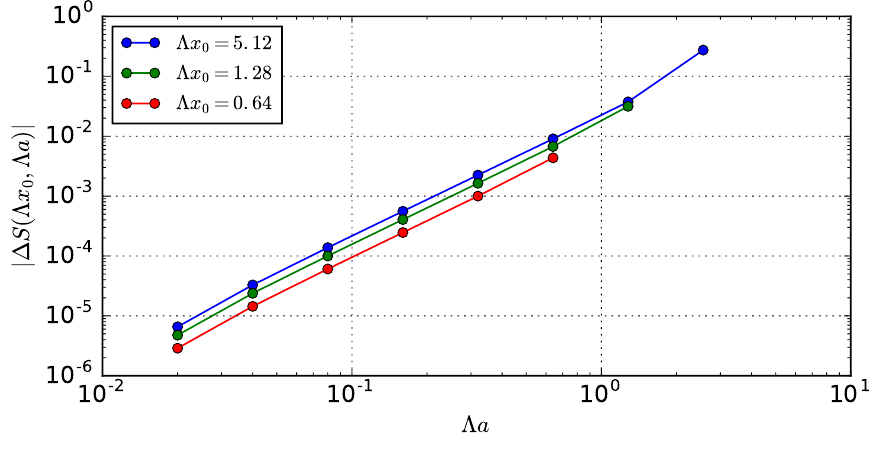
Figure 6 . Plot of the di(cid:11)erence j S ((cid:3) x 0 ; (cid:3) a ) (cid:0) S ((cid:3) x 0 ; (cid:3) a = 0 : 01) j that shows the convergence of this particular value of entropy upon iterative (cid:12)ne-graining of the sampling parameter used as a tool to compute it. The plotted di(cid:11)erence goes to zero approximately quadratically with (cid:3) a . S ( x ) to a (cid:12)nite value, rather than the divergence seen in the entanglement entropy of the CFT. Speci(cid:12)cally, (cid:12)gure 6 shows that for a (cid:28) 1 = (cid:3), the entanglement entropy of an interval converges to its (cid:12)nite value for a = 0 quadratically in a , S ( x ) = S ( x ) + O ( a 2 ). We will a take this value as our approximation to the entanglement